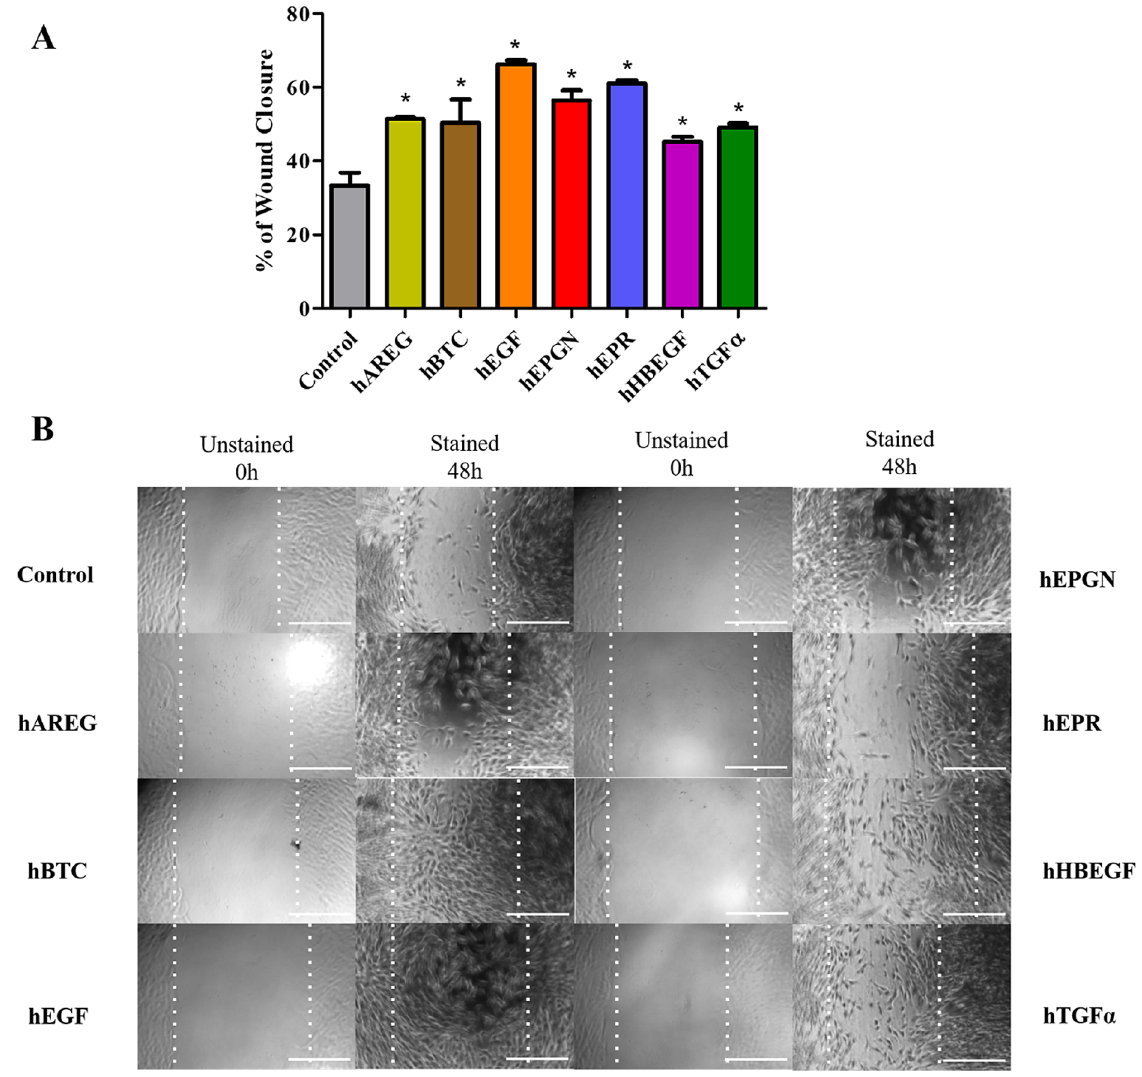
Figure 7. Scratch wound closure induced by the seven EGF growth factors. ( A ) Confluent cultures of NDFH cells were scratched with a sterile pipette tip and treated with 50 ng/mL of each EGF growth factor for 48 h. For quantification of the gap closure rates, the area of the gap at 48 h was compared to the area of the initial gap. Gap areas were determined with the ImageJ software using microscopic images as described in the Methods section. * p < 0.05. ( B ) Representative microscopy images at 100 X magnification acquired at time 0 (unstained living cells after the scratch) and after 48 h of fixed cells stained with violet crystal. The bar size is 100